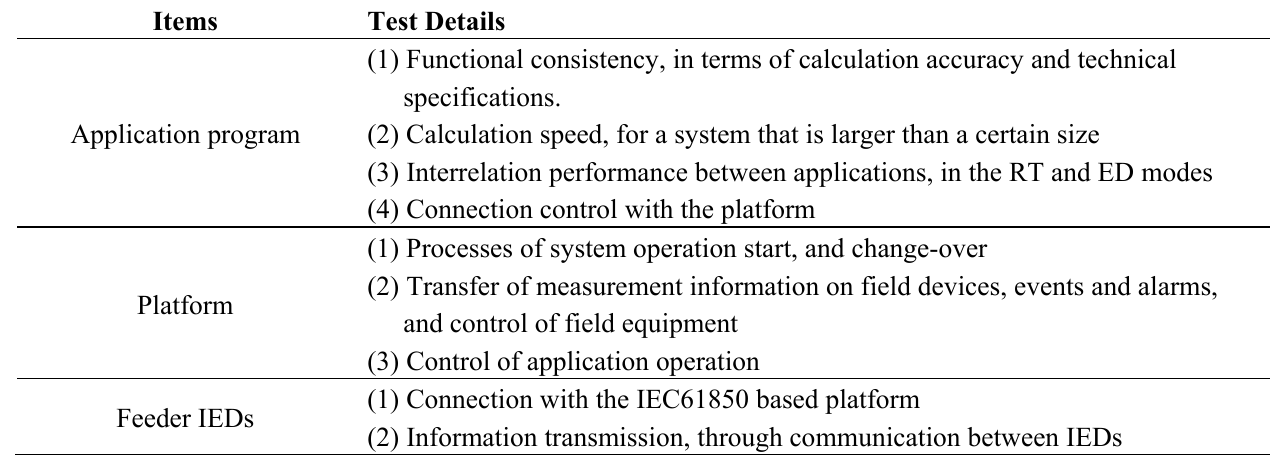
Table 6. Test details of the unit function and integration test.